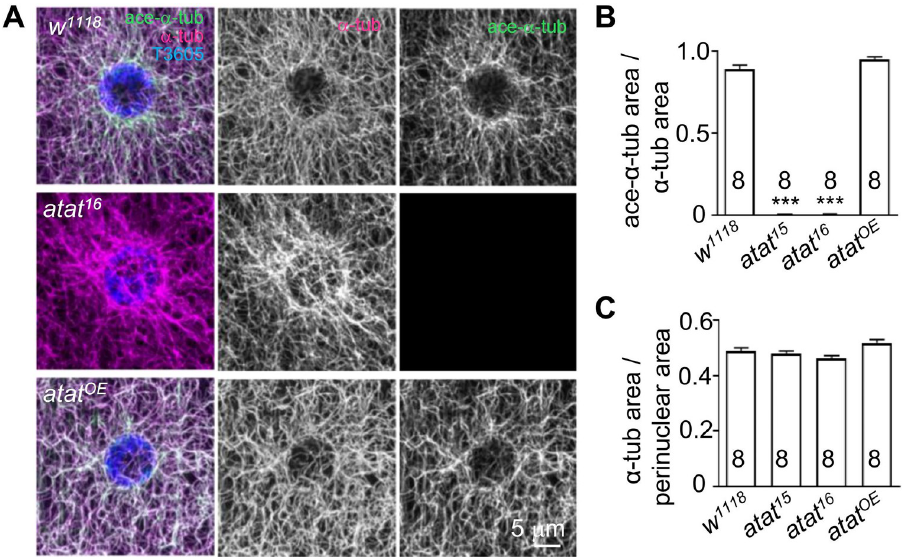
Fig 2. Depleting α -tubulin acetylation in muscle cells has a minor effect on the microtubule network. (A) The larval muscle cells of the control ( w 1118 ), atat 16 mutant, and larva with Atat overexpressed using C57-Gal4 ( atat OE ) were triple-stained with anti- α -tubulin (green), anti-acetylated α -tubulin (magenta), and TO-PRO(R) 3 iodide (T3605, blue). Scale bar: 5 μ m. (B and C) Quantification of the densities of acetylated microtubules (B) and total microtubules. Mean ± SEM. One-way ANOVA with Tukey’s multiple comparisons test. ��� p < 0.001. https://doi.org/10.1371/journal.pone.0280573.g002 12-second period (counted manually) by the number of seconds. Stride size was defined as the average distance traveled during one contraction [35]. To generate the plots in Fig 7B, the changes in body lengths during crawling were calculated using the “fit ellipse” function in ImageJ.